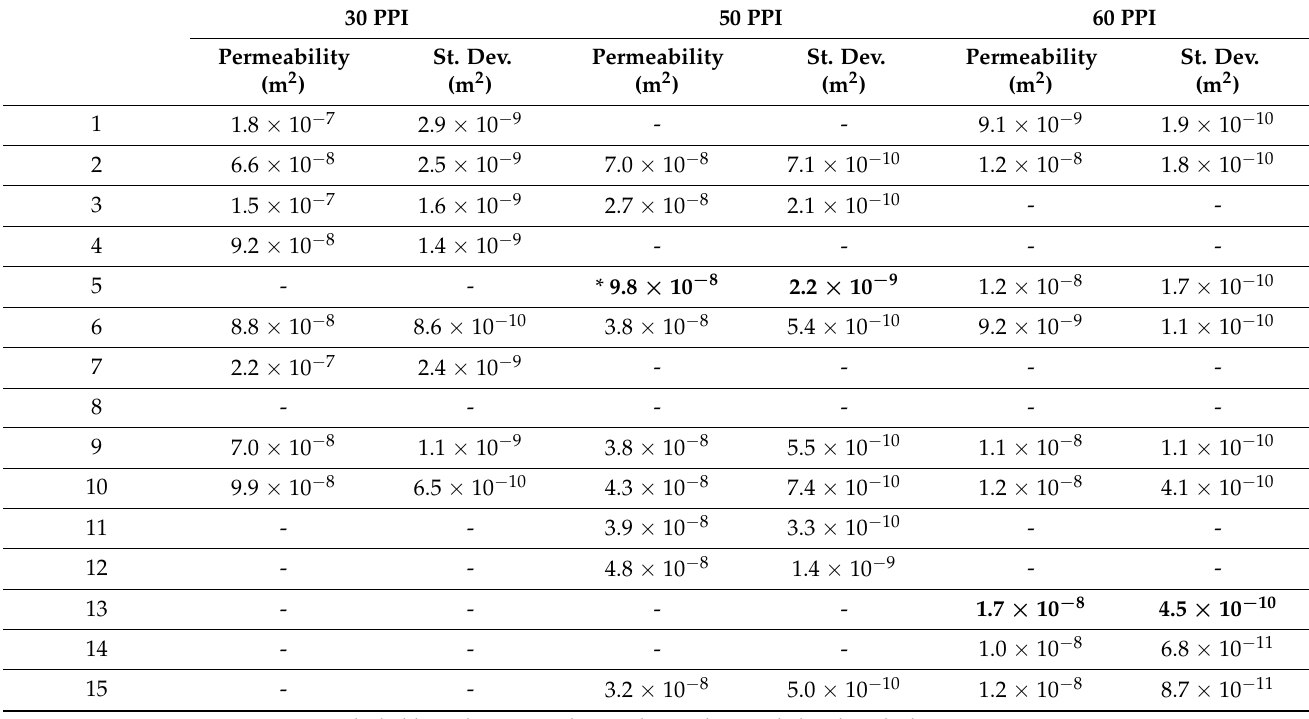
Table A16. Permeability of CFF samples of 30 PPI, 50 PPI and 60 PPI from supplier